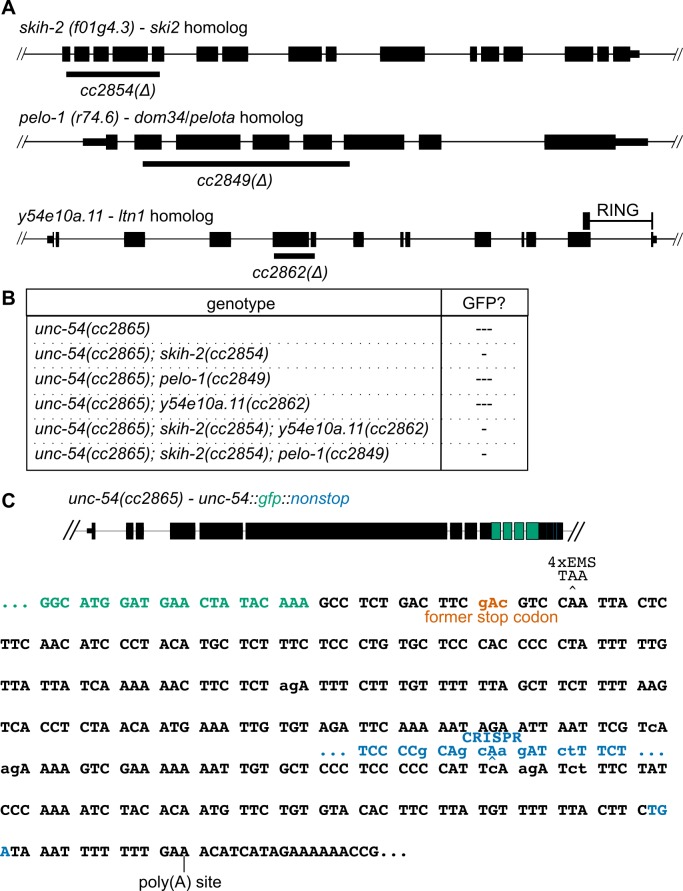
Results of candidate-based approach and genetic screen for nonstop suppressors.(A) Sequence homologs of factors known to affect nonstop decay in other systems. Large deletions creating premature stop codons were made by CRISPR/Cas9 in each factor, as indicated below each locus. Location of the y54e10a.11 RING domain indicated. All mutations led to grossly wild type animals. (B) Mutations in one or more factors were crossed into the unc-54(cc2865) nonstop reporter. ‘---' indicates a lack of detectable GFP fluorescence. ‘-' indicates very weak but detectable GFP fluorescence. (C) Summary of mutations that rescue expression or do not at the nonstop unc-54 locus. Diagram of the unc-54(cc2865) locus at top, with sequence and reading frame of C-terminus below. Mutations relative to the wild type unc-54(3’UTR) are indicated in lowercase. The wild-type stop codon location (‘former stop codon’) is indicated in red. EMS mutagenesis of PD2865 recovered at least four independent isolates of the indicated CAA >TAA the second codon after the former stop codon. These animals were indistinguishable from unc-54(cc2859). No additional 3’UTR-contained codons would be expected to mutate to a stop codon (TAA/TAG/TGA) given the mutational bias of EMS (G > A and C > T). CRISPR/Cas9 was used to shift the frame by a base (indicated in blue), leading to translation termination upstream of the poly(A) site, but did not rescue the Unc phenotype nor restore GFP expression. An additional screen with the unc-54(cc2865) reporter in the y54e10a.11(cc2862) background yielded a GGG(Gly)>GAG(Glu) mutation in GFP (not pictured), creating a splice site and a frameshift. These animals were non-Unc, but GFP negative.